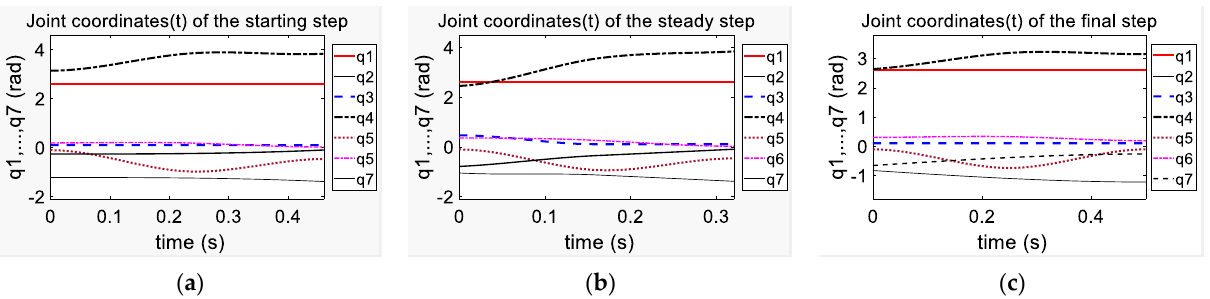
Figure 7. The motion of robot link: the joint coordinates (t) in the starting ( a ), steady ( b ), and final ( c ) steps.